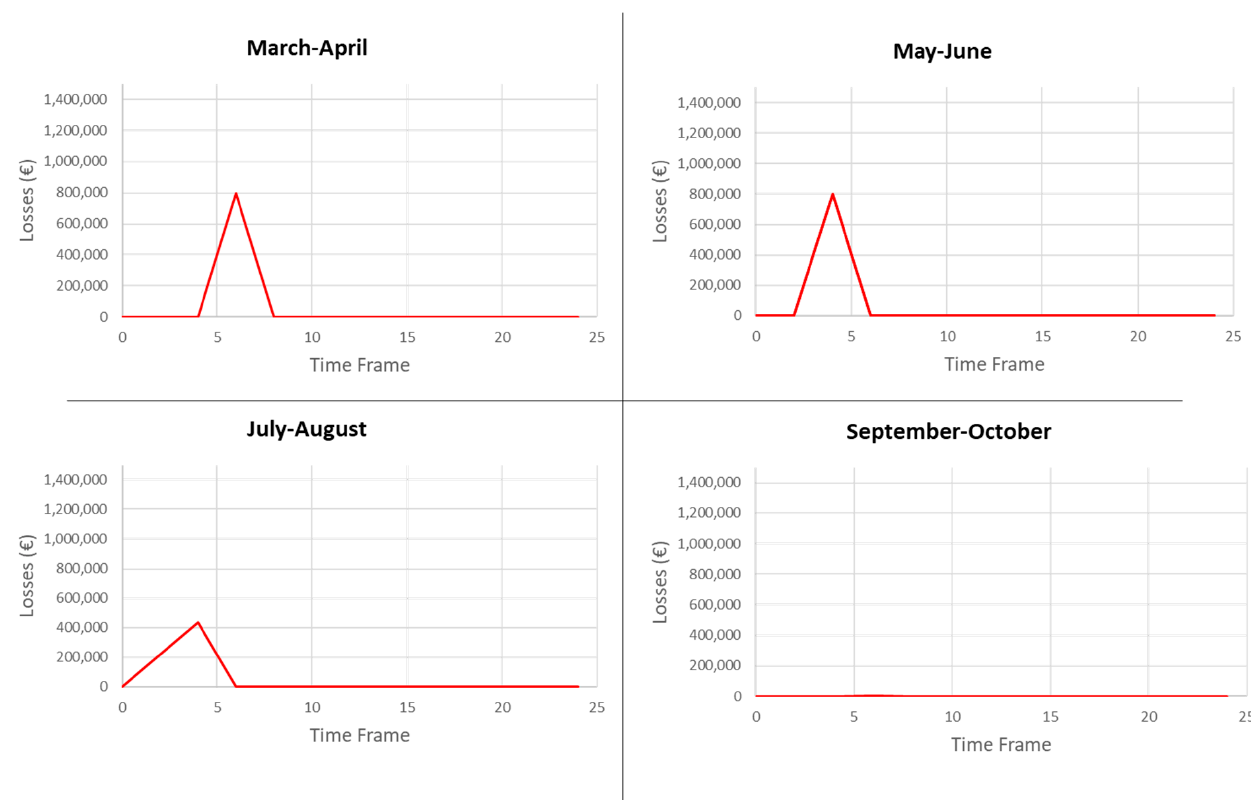
Figure 8. Losses in Basso Piacentino Monte due to over-use in Basso Piacentino Valle in Scenario